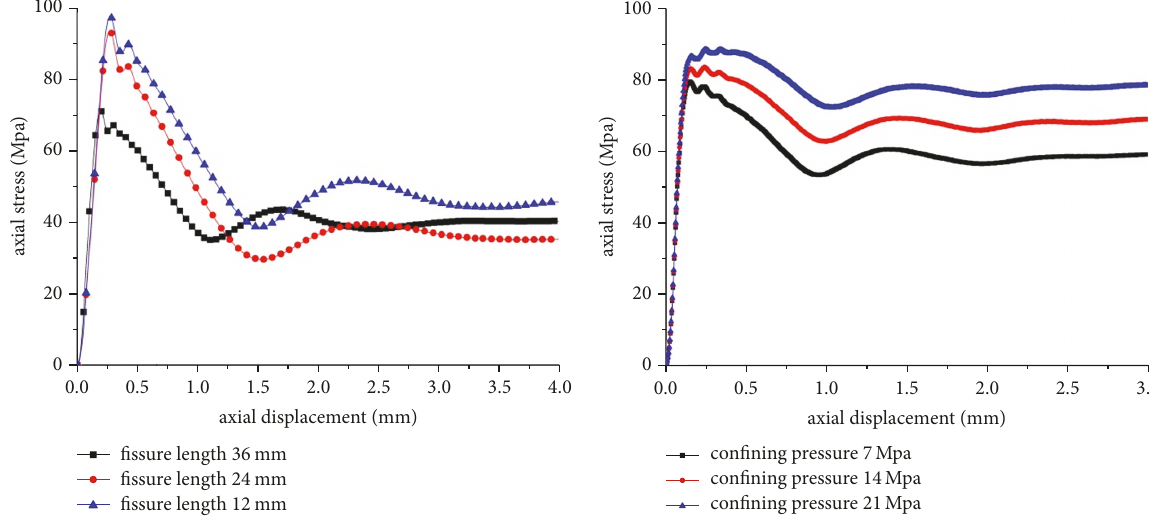
Figure 5: Relationship of axial stress and axial displacement.